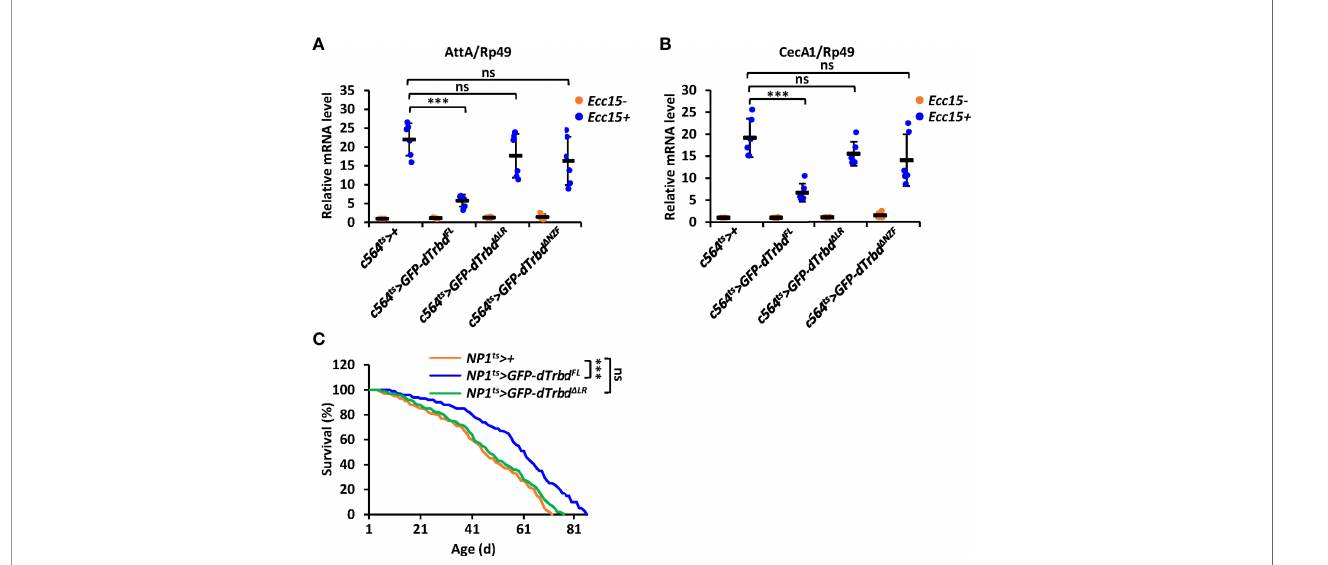
FIGURE 5 | dTrbd functions in vivo via multiple domains. (A, B) Male adults including c564 ts >+ (control), c564 ts >GFP-dTrbd FL , c564 ts >GFP-dTrbd D NZF , c564 ts >GFP-dTrbd D LR , and c564 ts >GFP-dTrbd D LR were infected with freshly cultured Ecc15 ( Ecc15 +) or not ( Ecc15 -). 12 h later, fl ies were harvested and lysed for RT-qPCR assays to examine the mRNA levels of AttA (A) or CecA (B) . (C) Male adults including NP1 ts >+ (control), NP1 ts >GFP-dTrbd FL , and NP1 ts >GFP-dTrbd D LR were subjected to lifespan assays. In (A, B) data are shown as mean ± SD. ***p < 0.001; ns, not signi fi